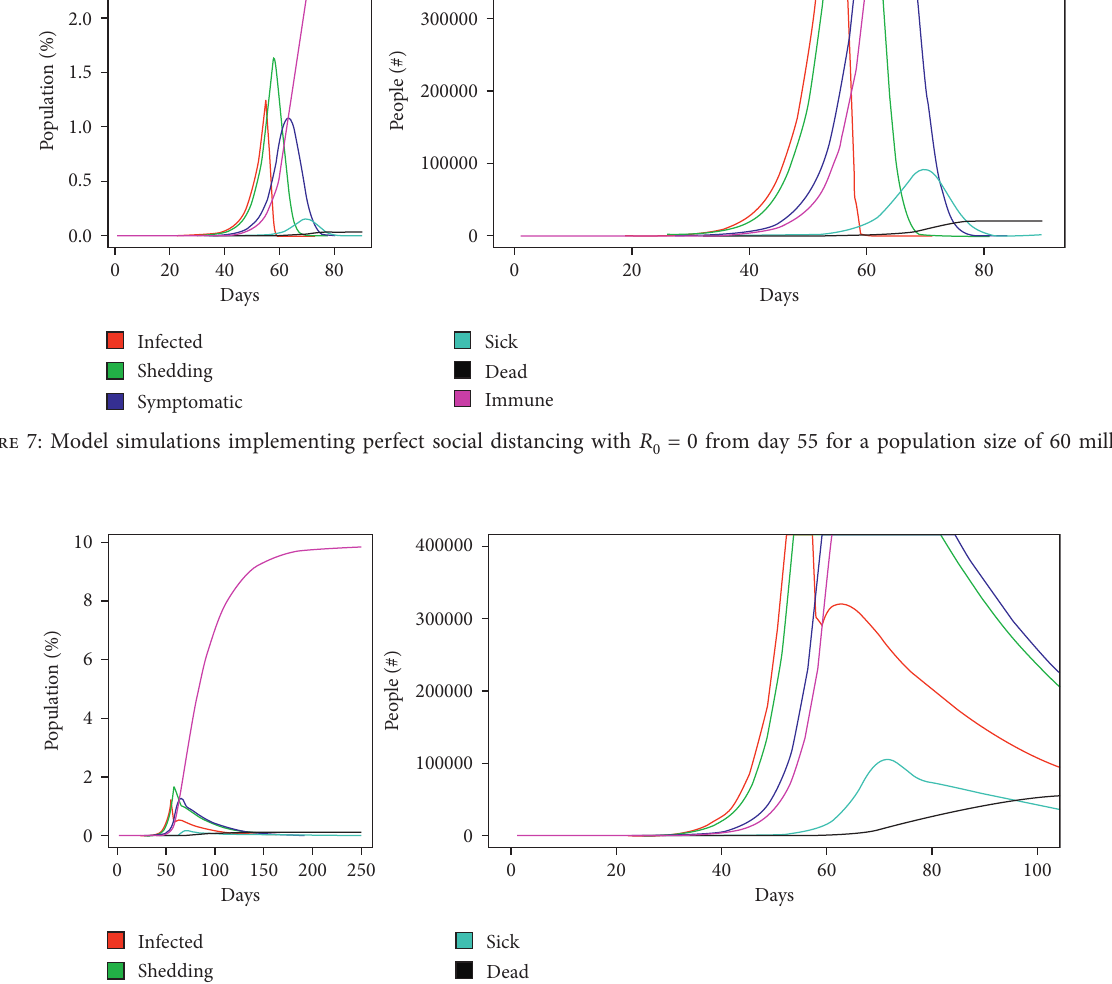
� 0 . 50 from day 55 for a population size of 60 million. 0